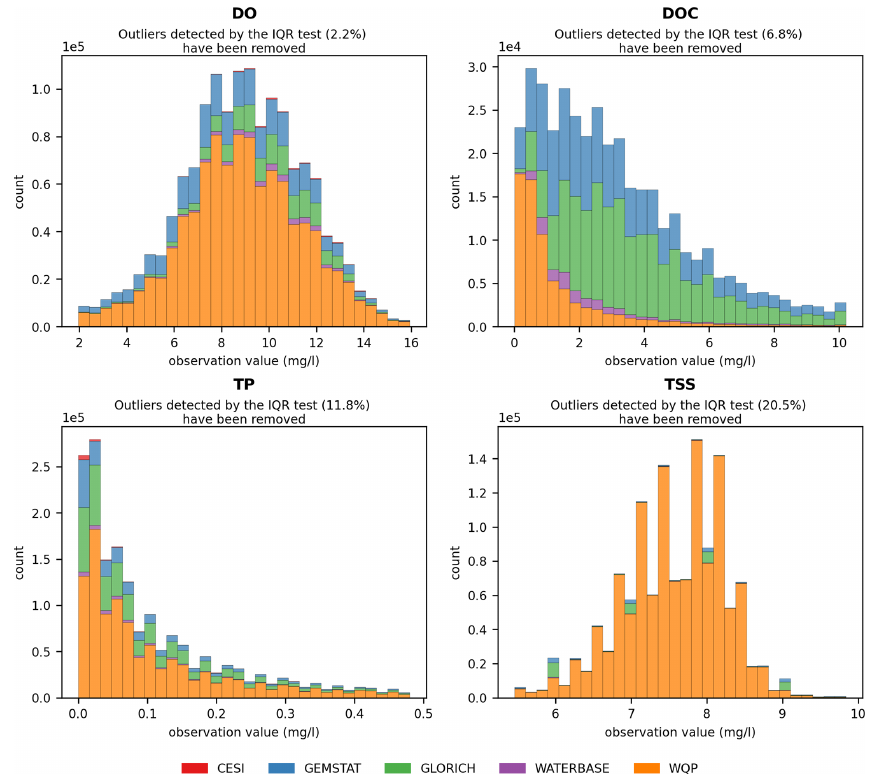
Figure 4. Distribution of observation values for dissolved oxygen (DO), dissolved organic carbon (DOC), total phosphorus (TP) and total suspended solids (TSSs). Outliers determined by the IQR test (Table 7) are not shown on the